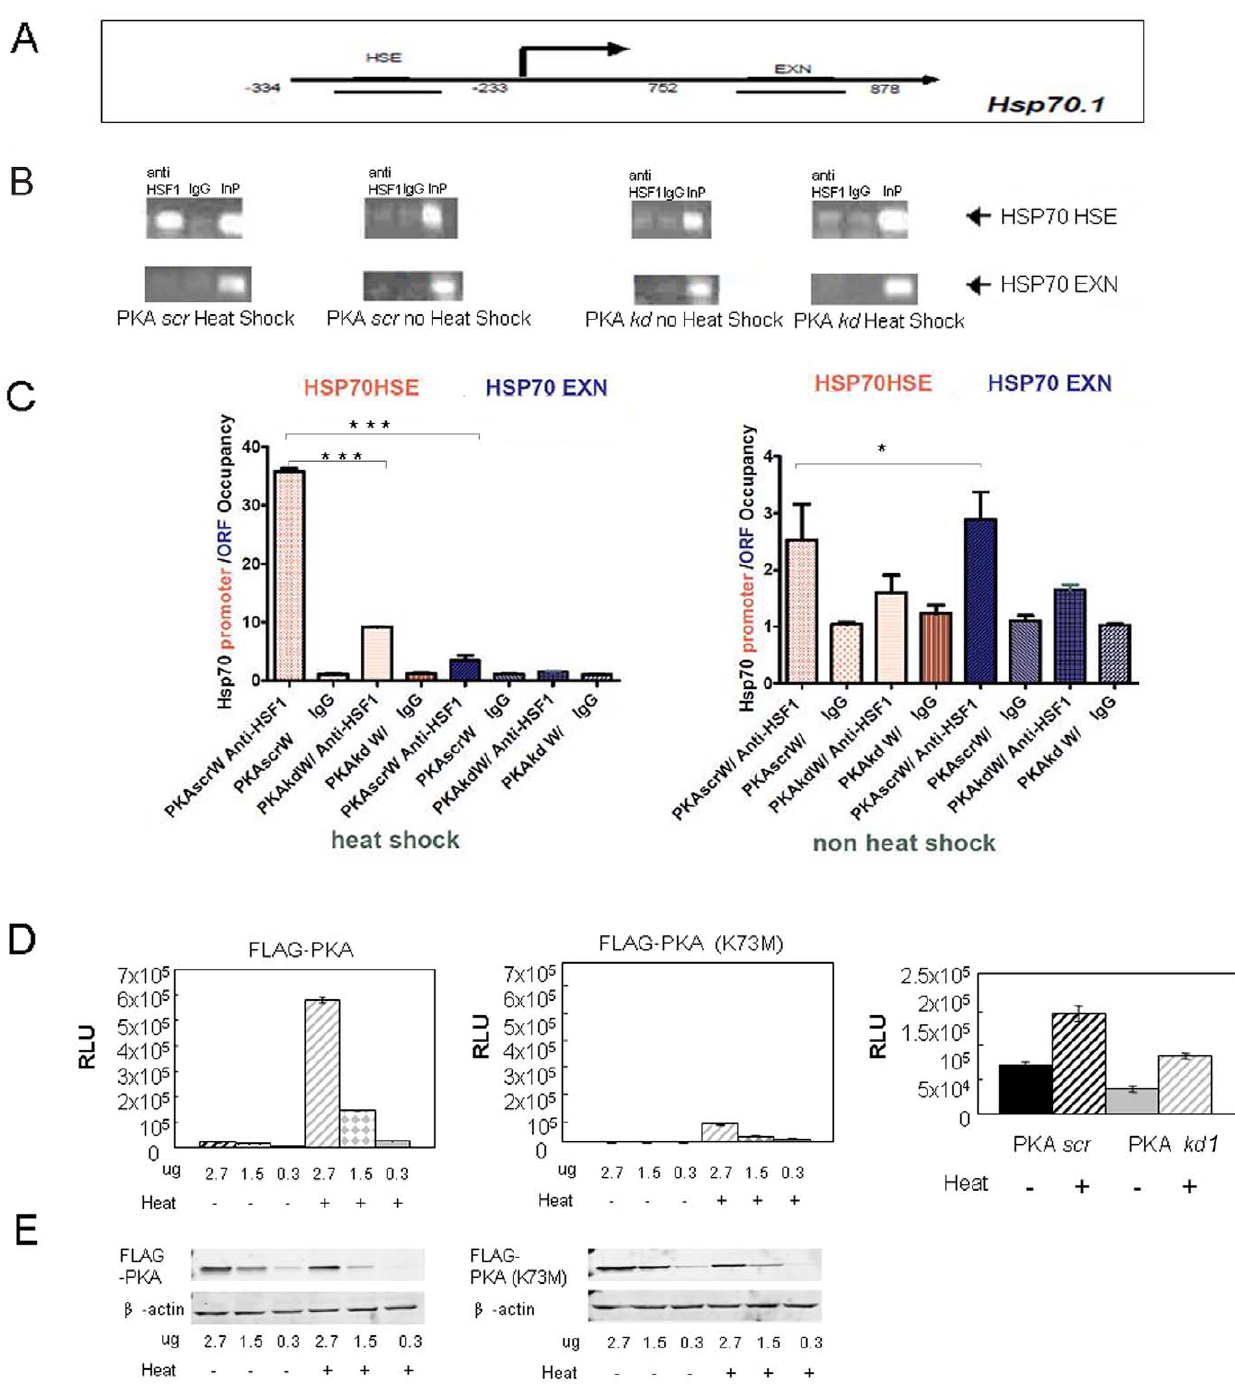
Figure 5. PKAc a knockdown inhibits HSF1 association with the hsp70.1 promoter. (A) Diagram of primers mapping to the hsp70.1 gene. B ) ChIP experiments. HeLa cells either with PKA knockdown (PKA kd # 1 ) or expressing a scrambled control RNA (PKA scr ) were incubated without or with heat shock (43 u C, 1 hr). Cells were then fixed with formaldehyde, sonicated and analyzed by ChIP assay using HSF1 antibodies or preimmune- IgG as control. The immunoprecipitated DNA was PCR amplified using the primers specific to the promoter (HSE, upper lane) or ORF (EXN, bottom lane) sequences in hsp70.1 . Each panel (from left to right) shows the PCR products from the HSF1 ChIP assay (anti-HSF1), IgG ChIP or from control sample of genomic DNA (input). Experiments were performed three times with similar findings. C ) ChIP PCR products were also analyzed using the ABI 7300 real time PCR system and the fold increase by 2 2 DD CT method. Levels of HSF1 ChIP PCR products were compared with the products associated with pre-immune-IgG and plotted for the respective regions of hsp70.1 . ChIP experiments were each performed at least 4 times with and data plotted as mean + SD with consistent findings. Differences in gene occupation by HSF under the different conditions were analyzed statistically by Student’s t test. Promoter occupancy by HSF1 after heat shock was significantly higher than in PKAc a knockdown cells or occupancy of Hsp70EXN regions with or without PKAc a and significance is indicated: *** p , 0.001 (left panel). Differences in HSF1 binding to promoter (HSP70HSE) or ORF regions (HSP70EXN) in non-heat shocked cells were not significant (p . 0.05). D ) Luciferase assay of Hsp70.1 promoter-reporter activation in response